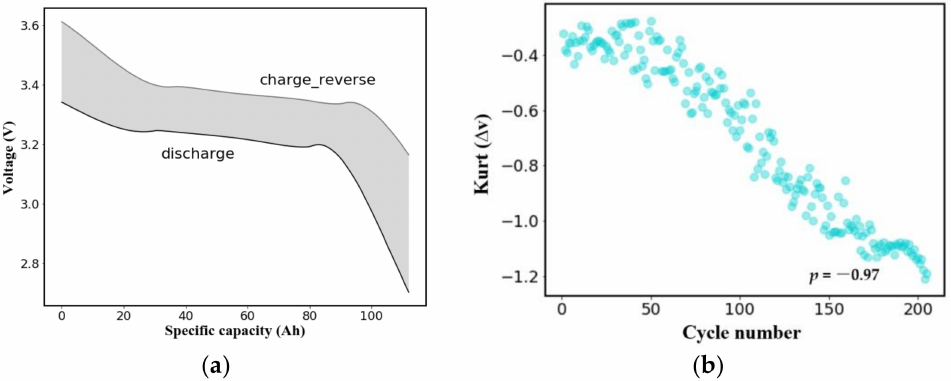
Figure 3. The charge/discharge voltage difference sequence ( a ) and their kurtosis values decrease with cycle numbers ( b ).